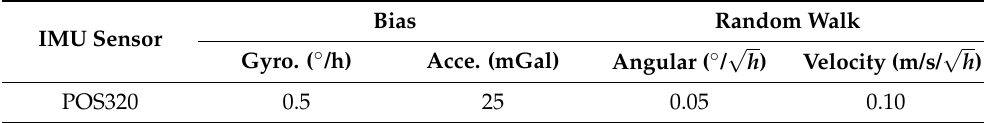
Figure 2. Mission details of vehicle test on 21 December 2021, in Beijing, China. Typical scenery in data collection areas (top left and top right); test platform and equipment (bottom left); and mission trajectory (bottom right). Table 1. Technical parameters of POS320.